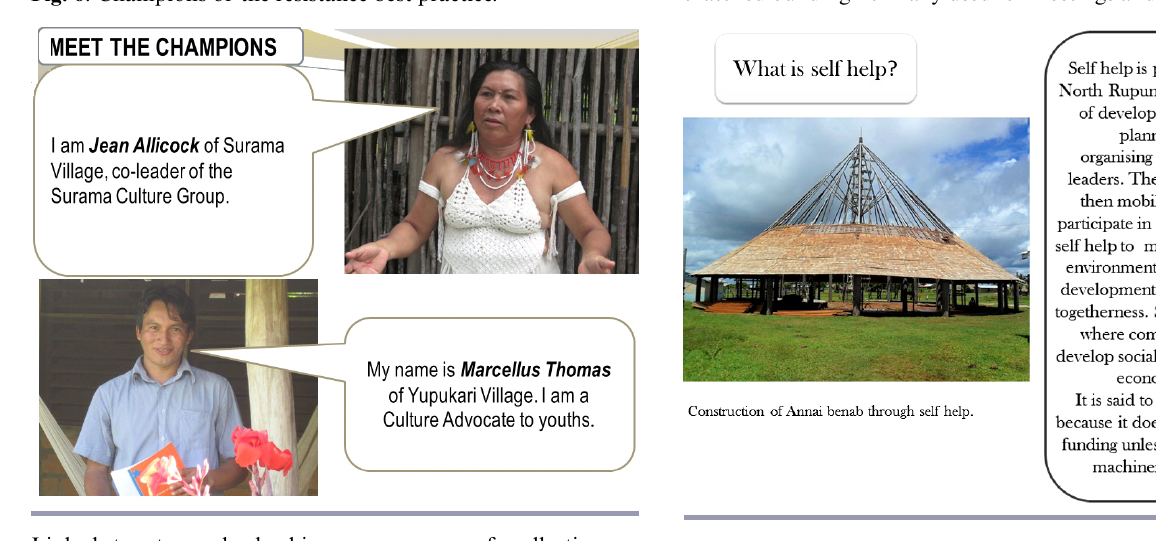
Fig. 7 . Explanation of self-help in the ideal performance best practice photostory. Note that a “benab” is a conical palm thatched building normally used for meetings and social events.